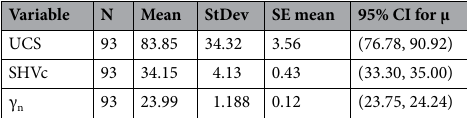
Table 1. Descriptive statistics of the data.